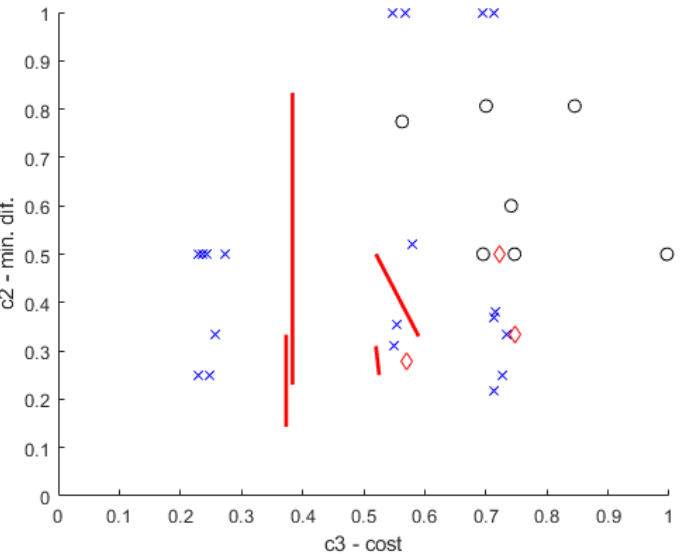
Figure 19. Results from all algorithms. Black ball—LHS. Red fronts and diamonds—GA, Blue